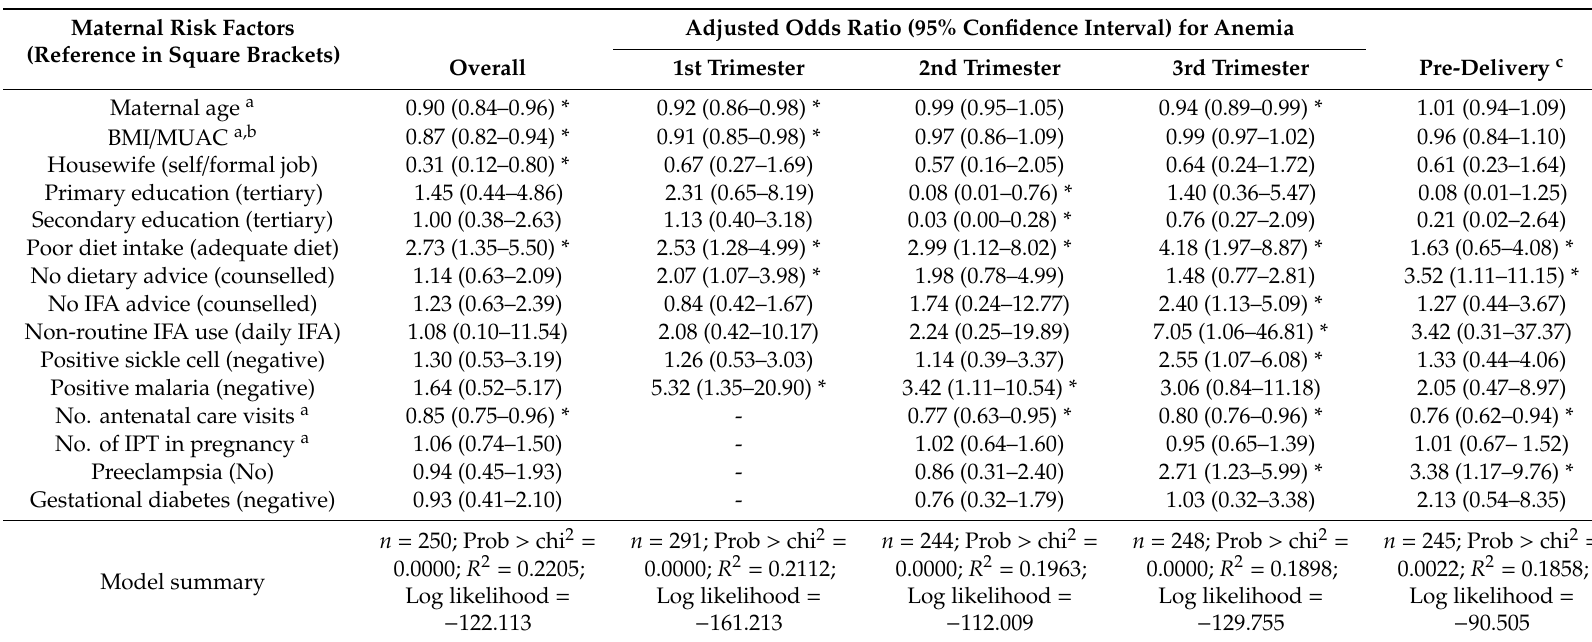
Table 4. Ordinal regression showing the adjusted odds for anemia in the first, second and third trimesters of pregnancy and at admission for labor and delivery. Maternal Risk